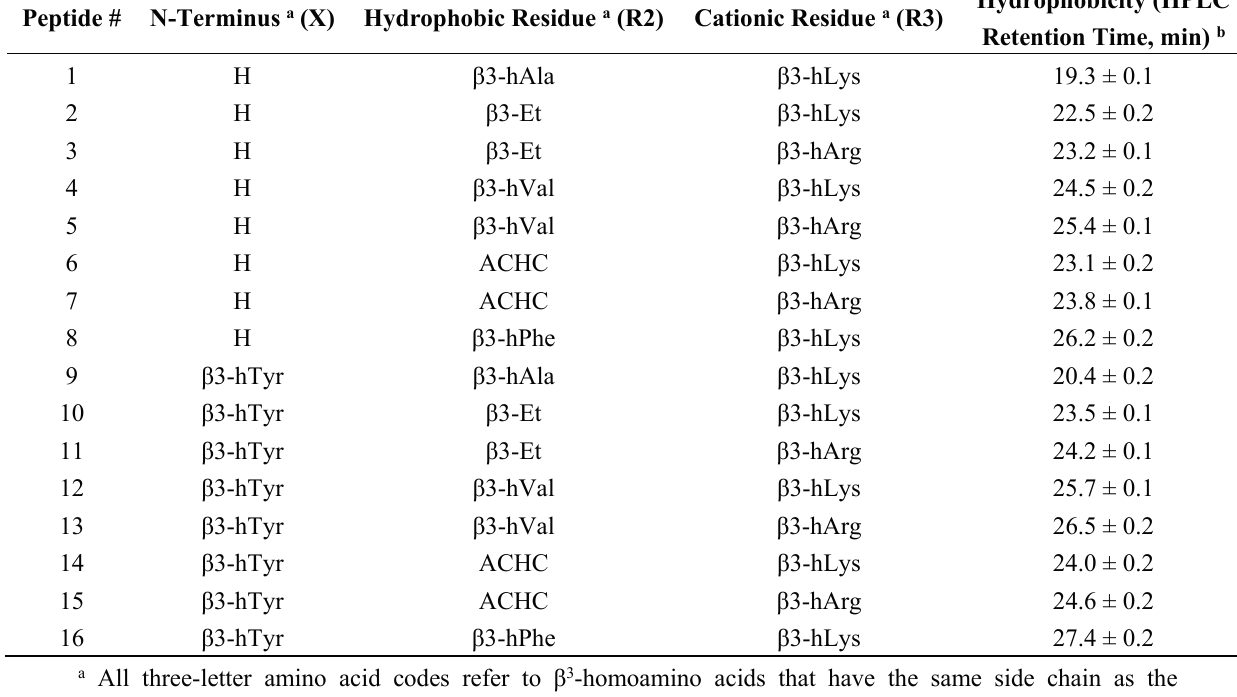
a All three-letter amino acid codes refer to β 3 -homoamino acids that have the same side chain as the corresponding α -amino acids. β 3 -Et refers to an ethyl side chain in the β 3 position and ACHC refers to trans -2-aminocyclohexanecarboxylic acid; denotes standard deviation of triplicate experimental measurements. Table 2. Minimum inhibitory concentrations (MICs) of peptides 1 – 8 against C. albicans clinical isolates. Peptide